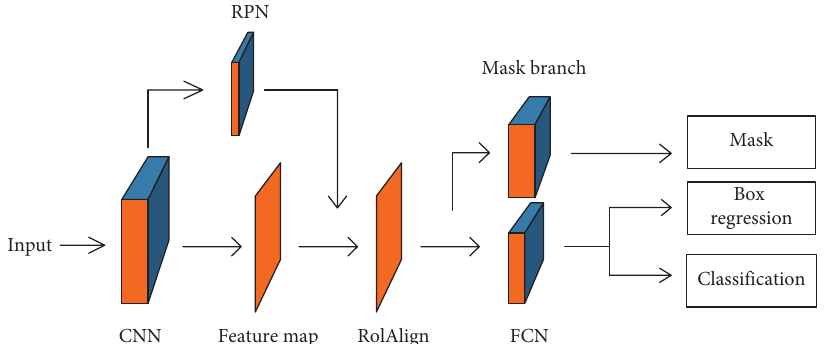
Figure 2: Overview of Mask